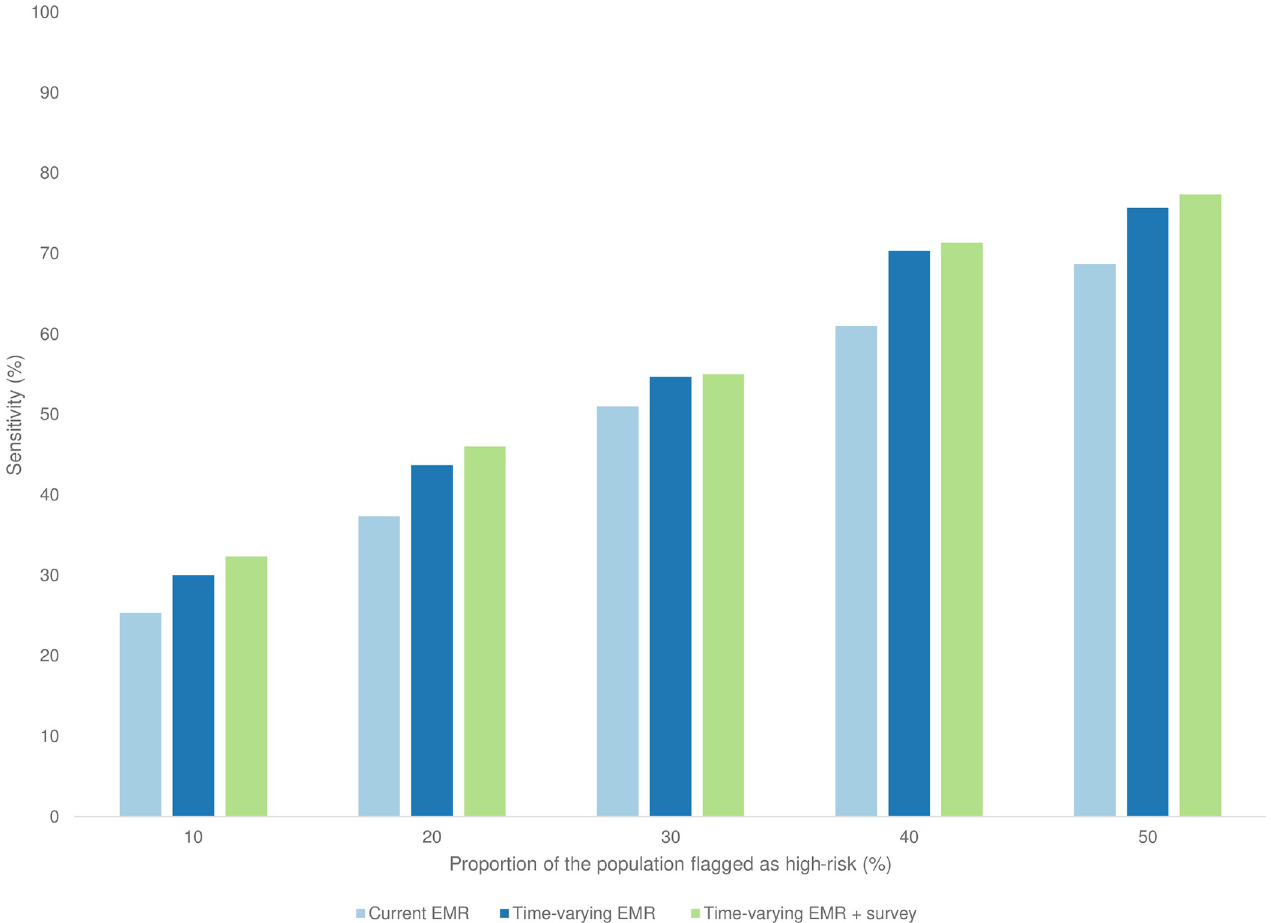
Fig 1. Mean model sensitivity for predicting risk of disengagement from HIV care at different risk score thresholds corresponding to the proportion of the total population flagged as “high-risk”, HIV treatment initiates in